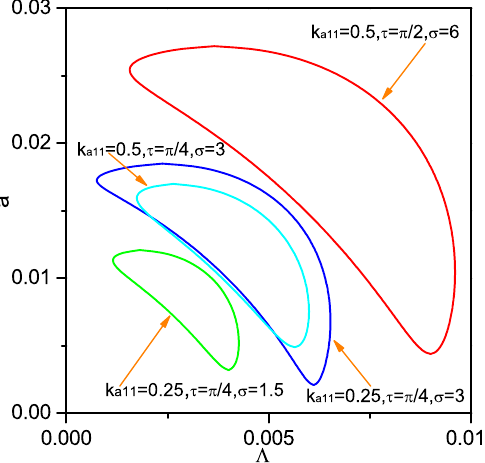
Figure 10. The response-excitation amplitude curve of the subharmonic